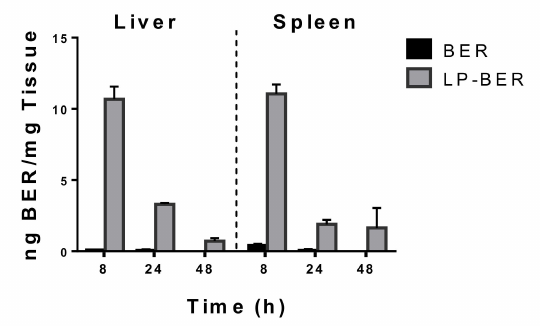
Figure 4. BER accumulation in livers and spleens after 8, 24 and 48 h post i.p. administration of 15 mg / kg of free BER or LP-BER. Data presented as mean ± SD, n = 3 mice per group.